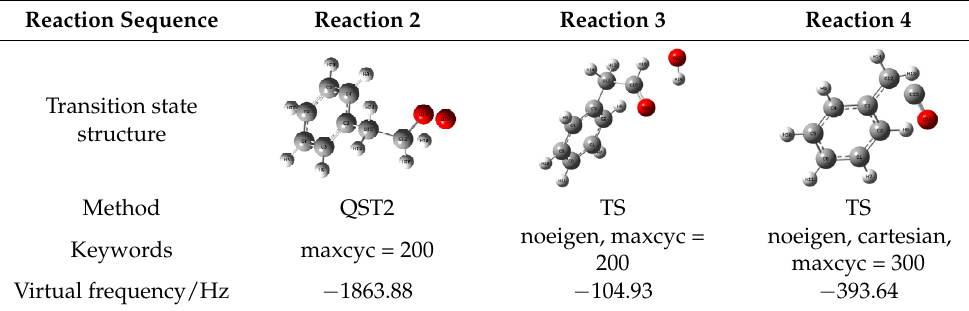
Figure 9. CO production model.